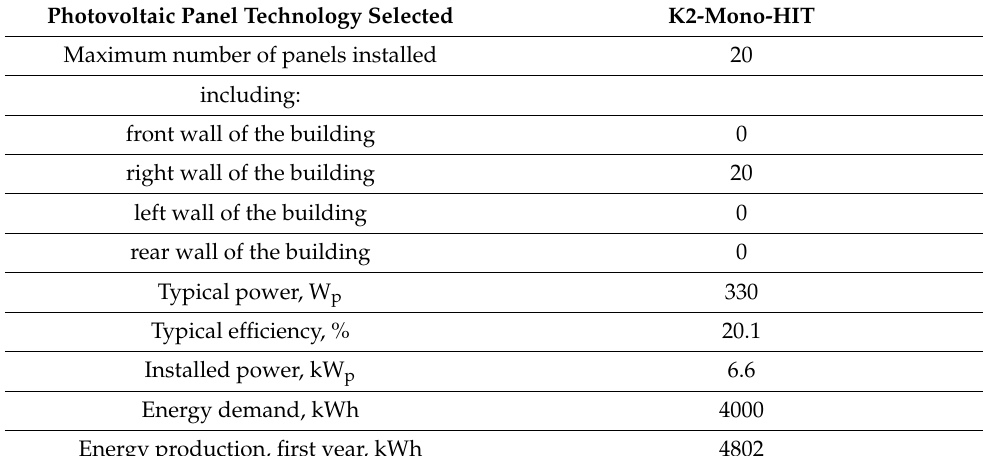
Table 12. Photovoltaic panel selection report by consumer preference.